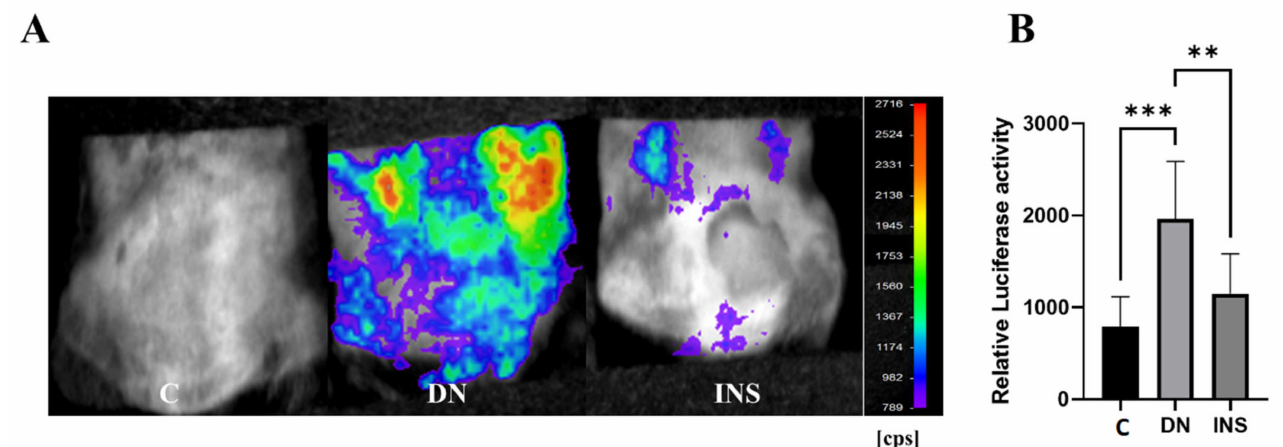
Figure 4. Bioluminescence imaging reveals renal pathology and therapeutic response of insulin in two-moderate-dose STZ-induced DN model using Saa3 promoter-luc mice. ( A ) The in vivo bioluminescence imaging from the back of Saa3 promoter-luc mice shows intense bioluminescence signal from the kidney tissues and how insulin treatment decreased the signal intensity, reflecting less severe injury in kidney of the insulin-treated mouse induced with two moderate-dose STZ injections ( n = 5). ( B ) Quantitative data ( n = 6). Data are presented as means ± S.E. ** p < 0.01, *** p < 0.001 as determined by ANOVA followed by Dunnett’s test. DN = Diabetic Nephropathy, C = Control, INS = Insulin